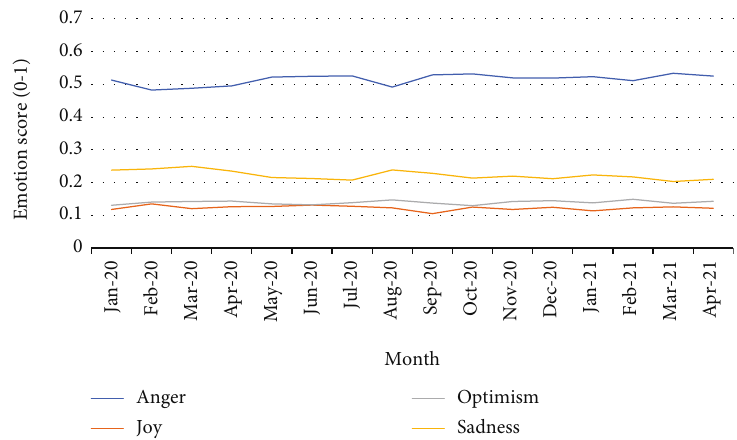
Figure 4: Chart showing monthly average emotion scores across the BBC News (UK) user tweets over time. User tweets are reactions to the BBC News (UK) news tweets shown in Figure 3.